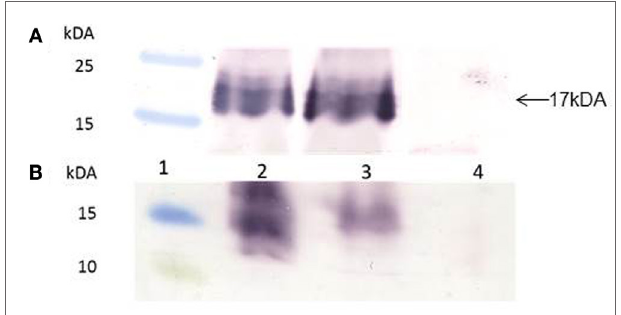
FigUre 2 | Western blots of human- and plant-codon optimized recombinant Zera ® M2e protein bodies (PBs) . Protein expression was detected with anti-Zera ® antibody and goat anti-rabbit antibody. (a) Transient expression in N. benthamiana . Plants were harvested 8 days post infiltration. Lane 1 contained PageRuler ™ Prestained protein ladder (Fermentas), lane 2 contained the Zera ® M2e plant-codon optimized protein, lane 3 contained the Zera ® M2e human-codon optimized, and lane 4 contained non-infiltrated control plant. (B) Expression of recombinant baculovirus in Sf 21 insect cells, 72 h post infection (hpi), using the Bac-to-Bac © baculovirus expression system. Lane 1 contained the PageRuler ™ Prestained protein ladder (Fermentas), lane 2 contained the recombinant human-codon-optimized Zera ® M2e PB, lane 3 is the recombinant plant-codon-optimized Zera ® M2e, and lane 4 contained the negative cell lysate transfection